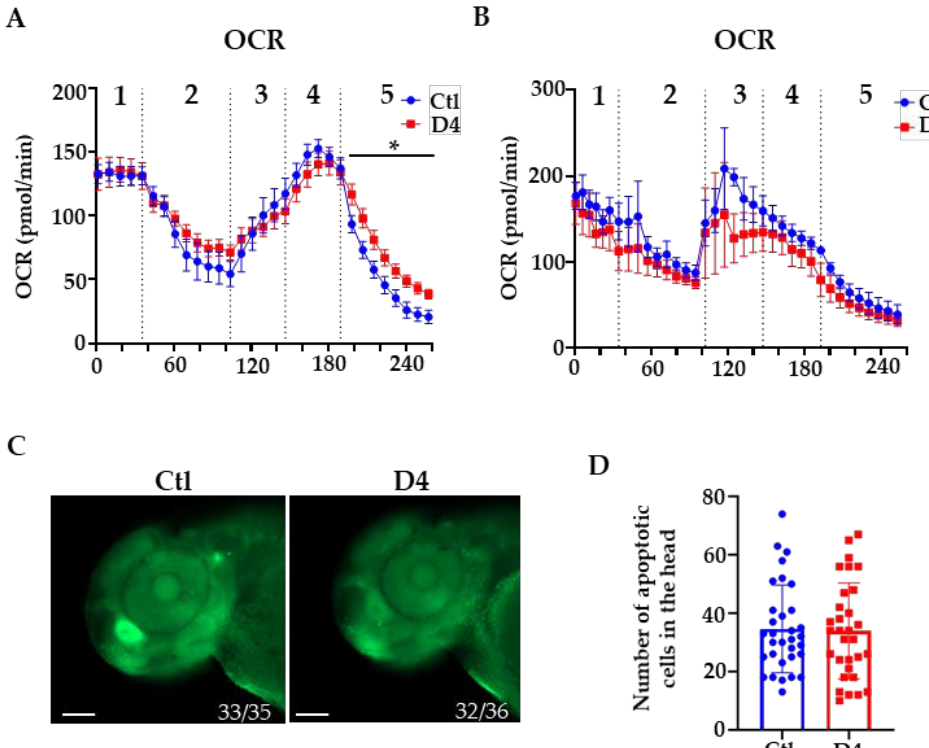
Figure 3. Oxygen consumption rate (OCR) and cell death analysis . ( A ) Oxygen consumption rate (OCR) in control (Ctl) and mutant (D4) embryos at 48 hpf (Ctl N = 9; D4 N = 10) and ( B ) at 72 hpf (Ctl N = 9; D4 N = 10). 1 = basal rate; 2 = 10 µ M oligomycin, 3 = 1 µ M FCCP; 4 = 2 µ M FCCP; 5 = 1 µ M rotenone and antimycin A. * p < 0.05, Student’s t -test. ( C ) Lateral view of acridine orange stained embryos at 48 hpf. The numbers at the bottom of the images indicate the ratio between embryos with the observed phenotype and the total number of stained embryos. Size bar = 100 µ m. ( D ) Quantification of acridine orange positive cells in the brain region (Ctl N = 33, D4 N = 32; two biological replicates).